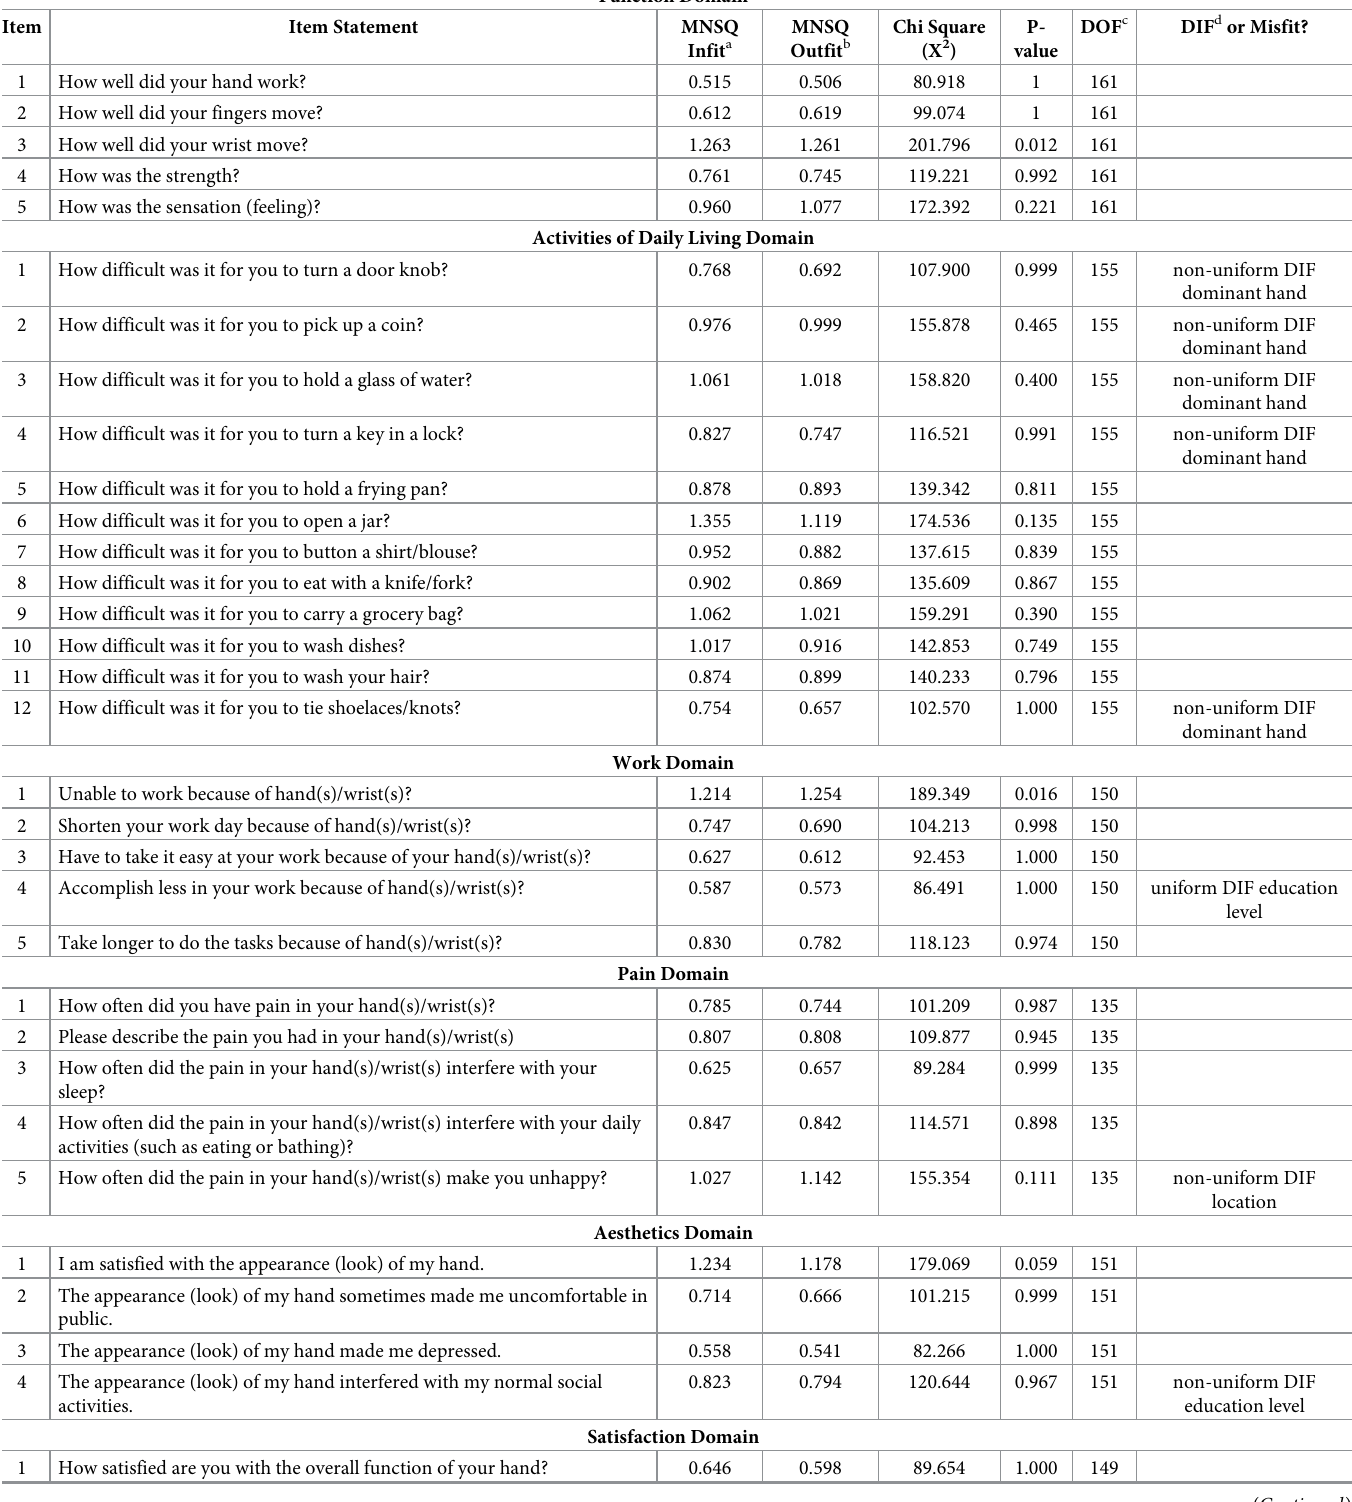
Table 3. Fit to the Rasch